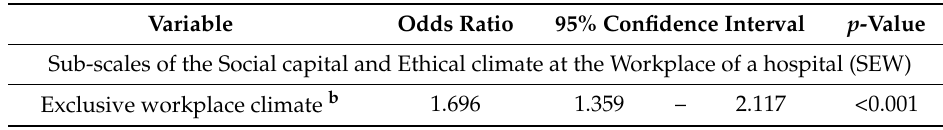
Table 6. Multivariate logistic regression model for SPD ( n = 822) a